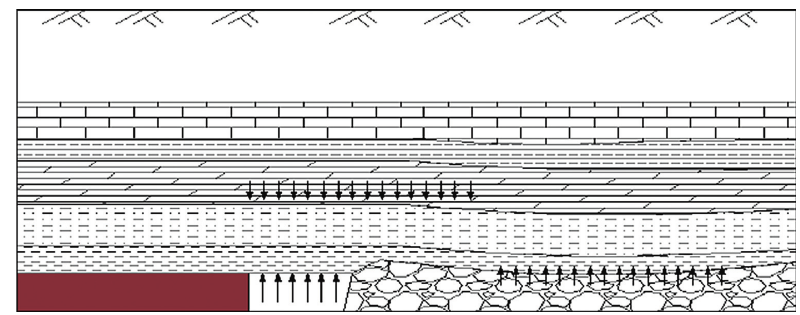
Figure 4: Schematic diagram of movement of overlying strata above the fully mechanized coal mining face backfilled with